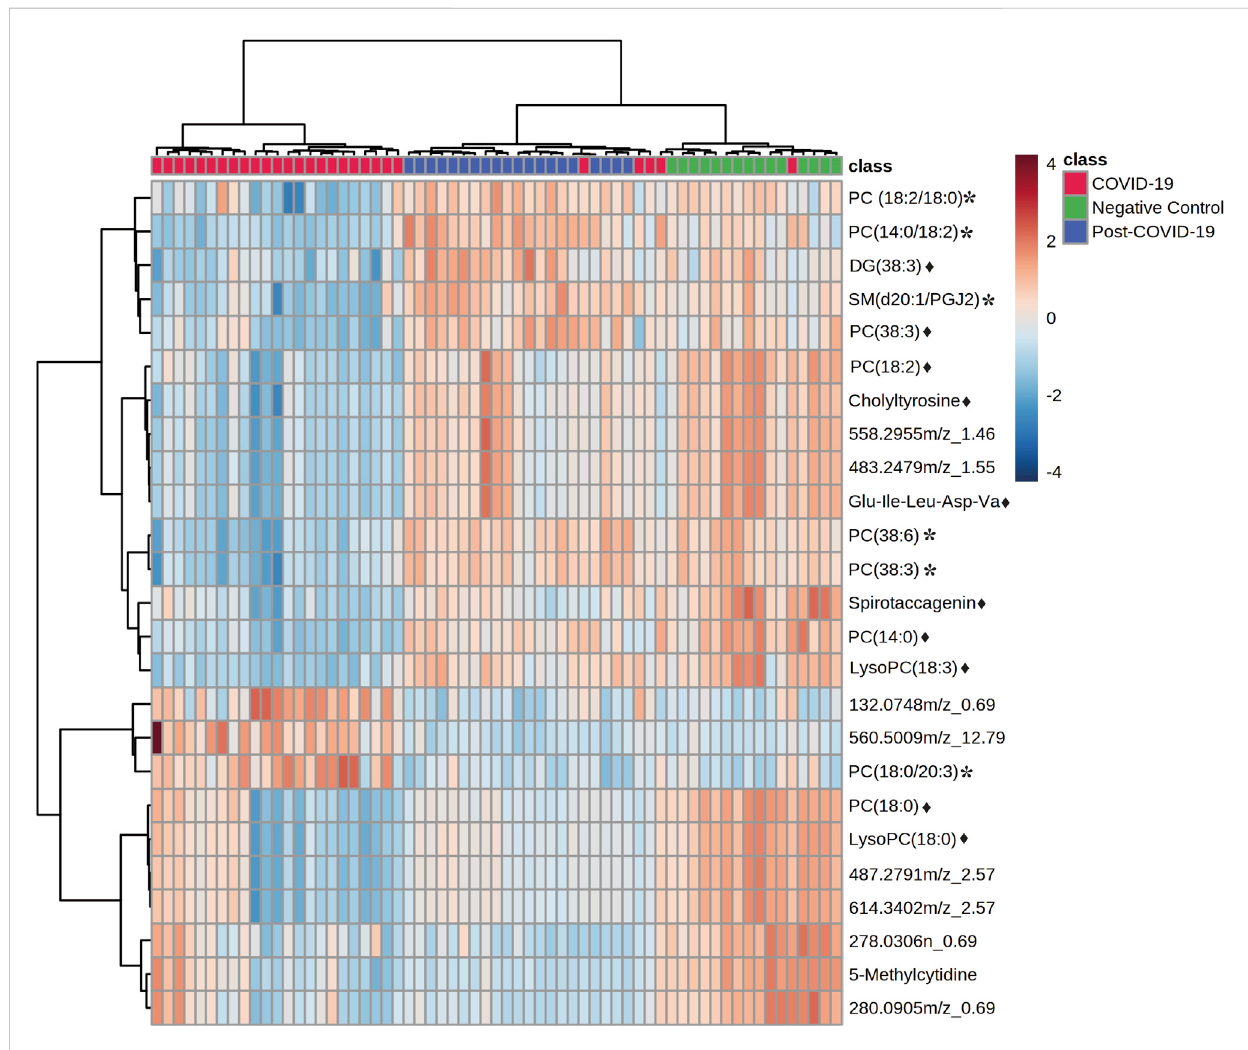
FIGURE 4 Heat map representing the most important features differentiating negative controls, post-COVID-19 patients, and COVID-19 patients. Data was normalized, distance measure: Euclidean, clustering method: Ward. Ranked by ANOVA test. Figure was built with MetaboAnalyst software v 5.0 (https:// www.metaboanalyst.ca). * Represents features with con fi dence level 2 and ◆ represents features with level